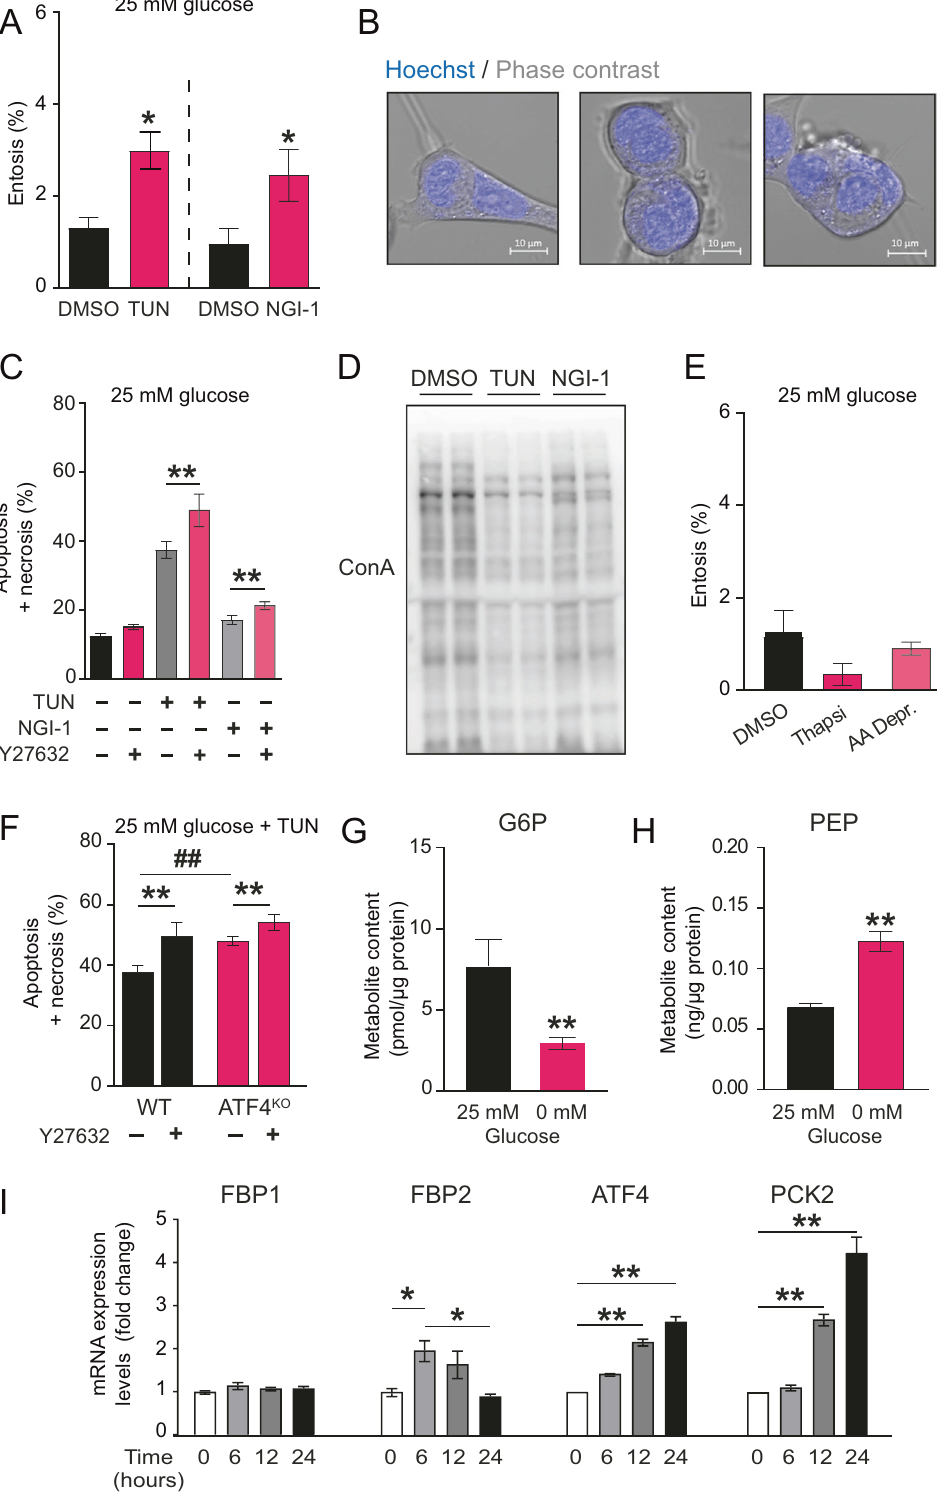
inducing ER-stress with thapsigargin, an inhibitor of SERCA calcium pump, or amino-acid limitation that activate the GCN2 dependent pathway (Fig. 2E). Neither thapsigargin or amino-acid limitation reproduced the increment in entosis observed using tunicamycin or NGI-1 in the presence of glucose, therefore, ER-stress was not